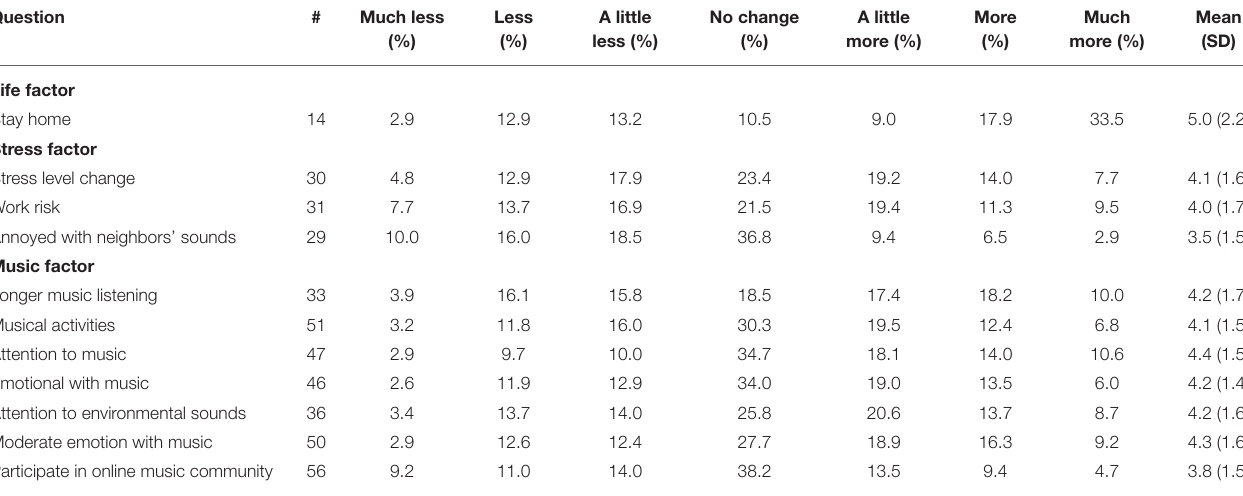
TABLE 6 | Responses to key questions employing PS-4 (four-point positive-sided ordinal scale), both belonging to life factor. Question